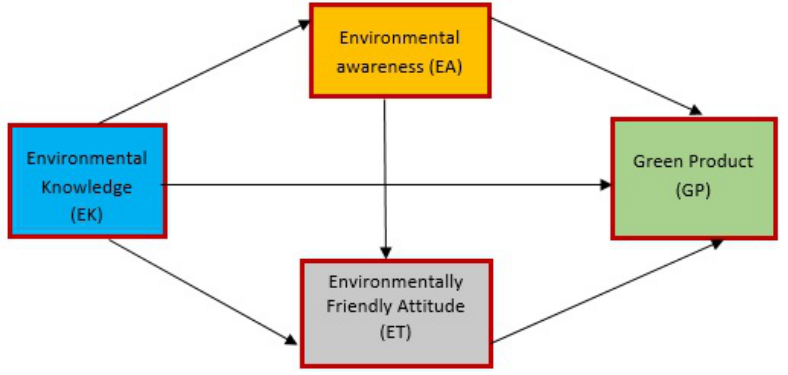
Fig. 1: The conceptual framework of research work Table 1: Measurement method (questionnaire and scaling)